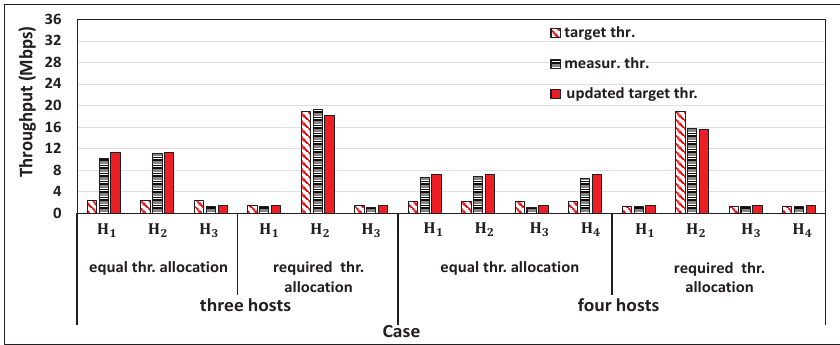
Figure 14. Measurement results of concurrent throughputs with saturated host .